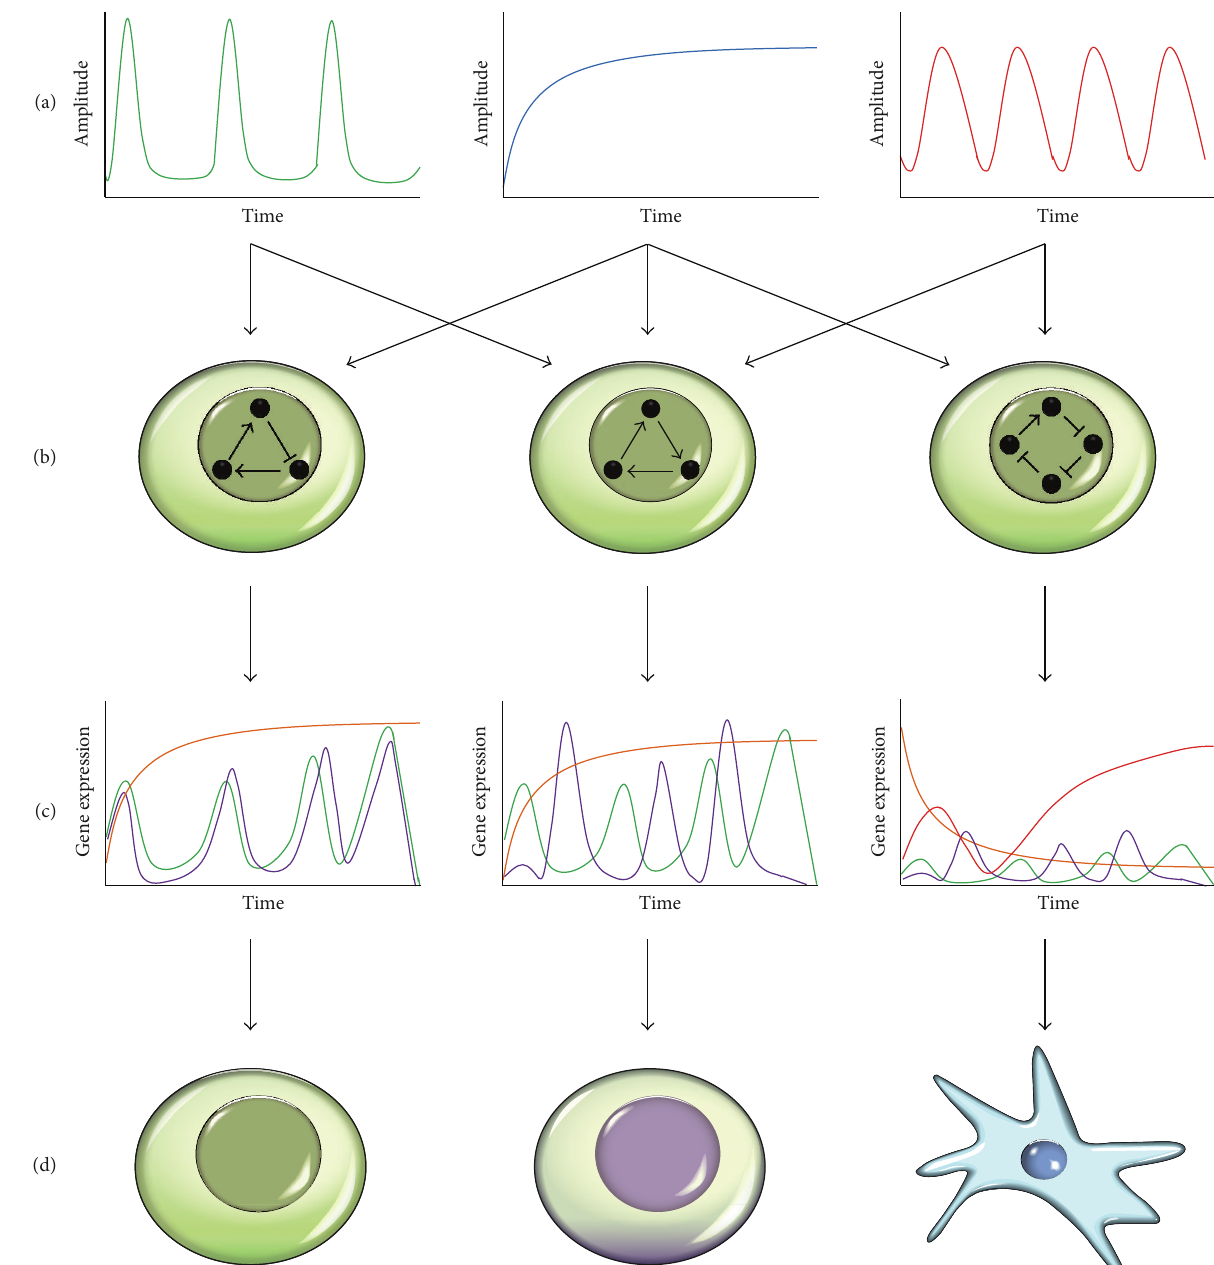
Figure 2: Emergence of gene expression heterogeneity in ESCs and cell fate determination. Gene expression heterogeneity of ESCs is determined by complex multistep mechanisms. (a) Multiple spatiotemporal restricted signals are differentially sensed and integrated by ESCs, leading to signaling pathways activation, which ultimately converges both onto the TRN and directly onto the chromatin. (b) Specific regulatory networks, which involve both TFs and epigenetic regulators, are established in the cell according to their transcriptional and epigenetic landscape and transduce the signals. Arrows and lines indicate positive and negative regulation between factors (black circles), respectively. Negative feedback loops (left) or incoherent feedforward loops (right) may generate oscillatory responses to signals. (c) The result of this integration is the fluctuation of genes expression profiles among cells, which permits ESCs to fluctuate in a continuum of interconvertible pluripotent states and may generate the suitable condition to exit pluripotency and differentiate. (d) The final biological outcome of this process is the establishment of a heterogeneous population of ESCs captured at different pluripotent states (green and purple cells) or the eventual differentiation toward committed cell (blue